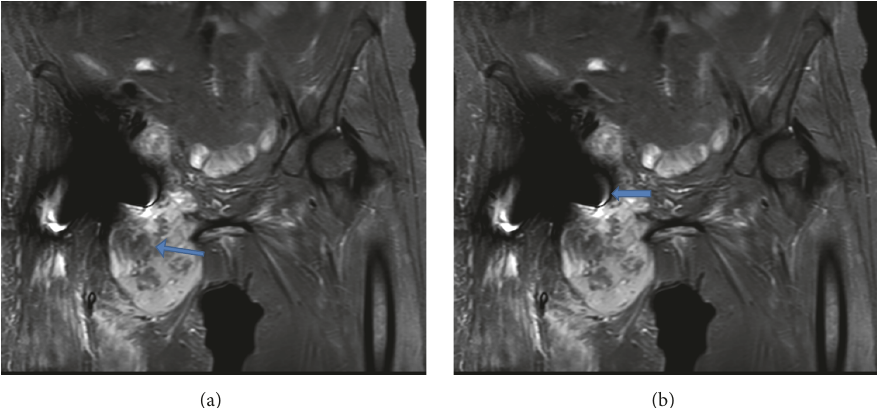
Figure 4: (a) T2 weighted images showing a lesion with central liquefaction necrosis. (b) T2 weighted images showing the close proximity of the lesion to the medial side of the prosthesis with effusion into the